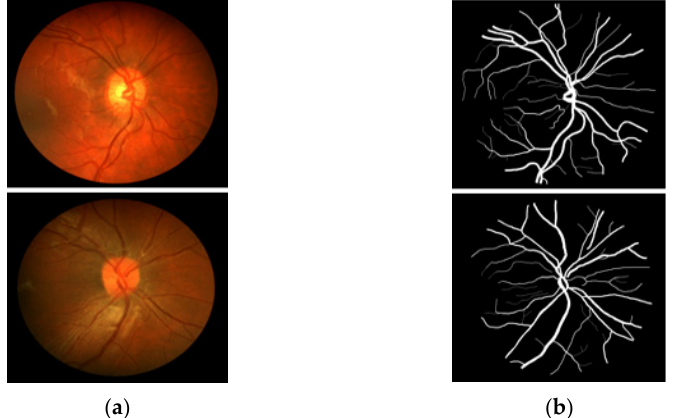
Figure 3. Example images from CHASE-DB1: ( a ) Original input image and ( b ) Expert annotation